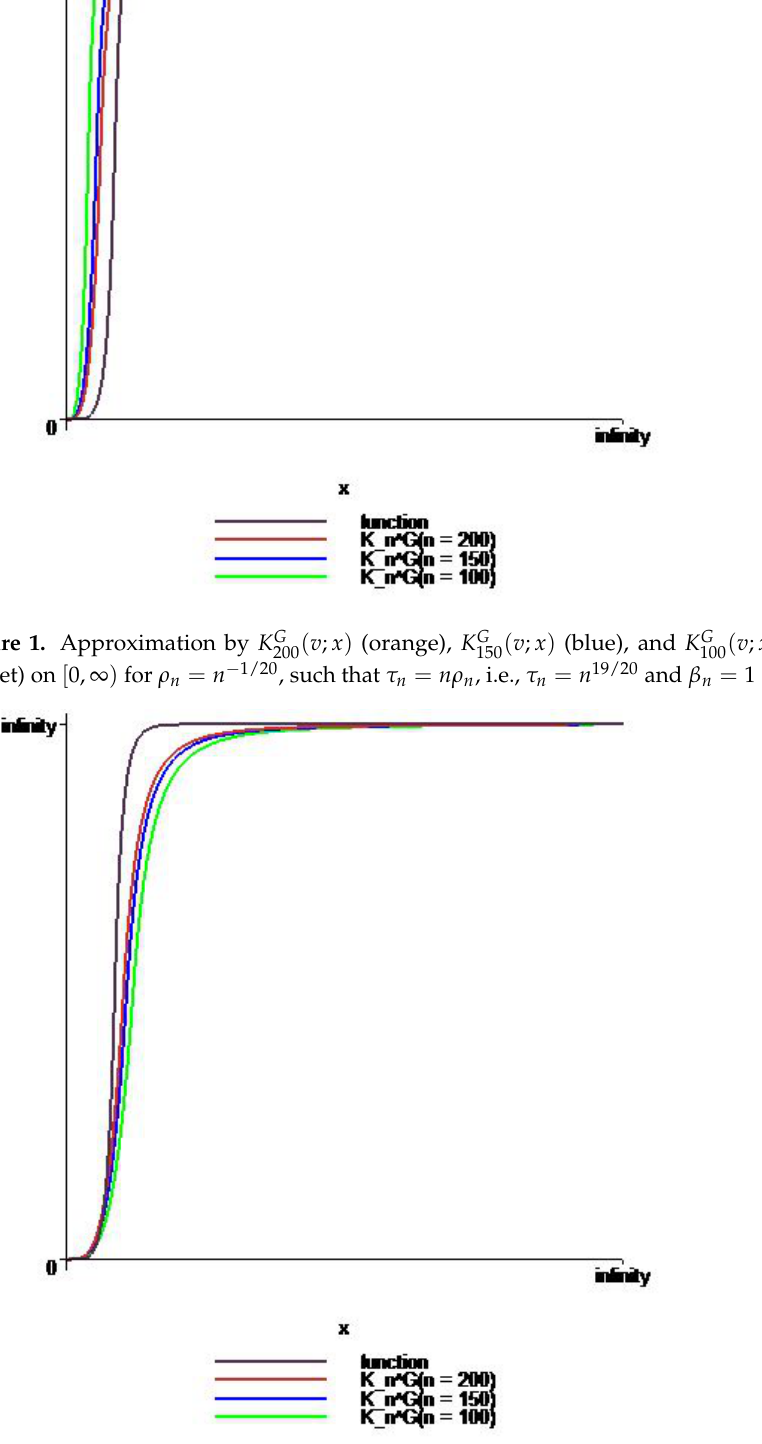
( v ; x ) (blue), and K G ( v ; x ) (green) to v ( x ) ( v ; x ) (orange), K G 200 150 100